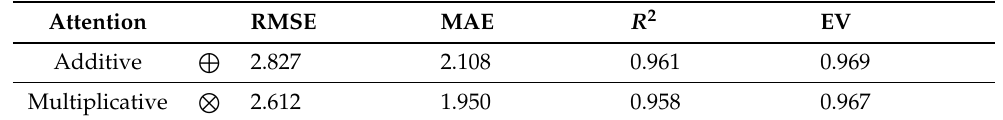
Table 7. Averaged validation metrics per configurations of the attention mechanism. (cid:76) is the additive attention mode, while (cid:78) is the multiplicative attention mode.